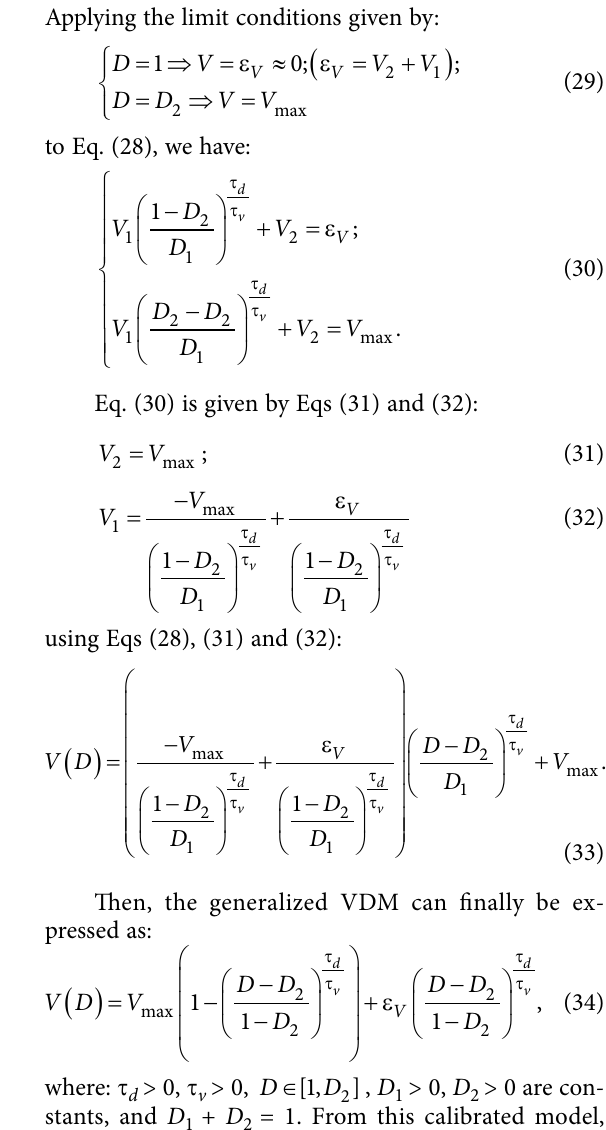
Table 5. Parameters of the D and v functions with γ = 0.8 Parameter